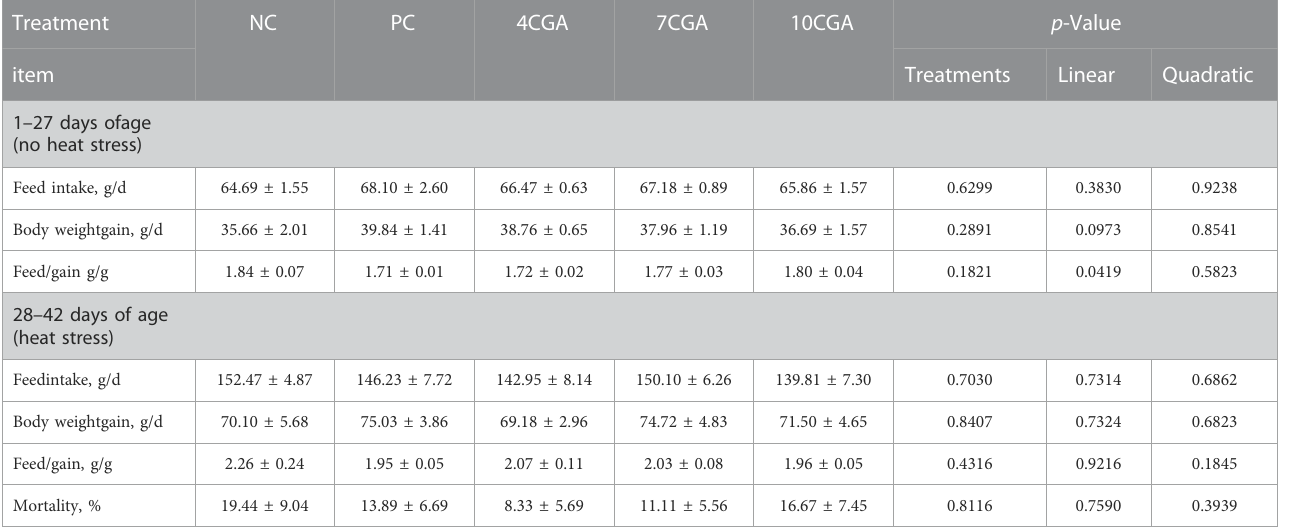
TABLE 2 Effects of in ovo feeding of chlorogenic acid on production performance and mortality of broilers. Treatment NC PC 4CGA 7CGA 10CGA p -Value item Treatments Linear